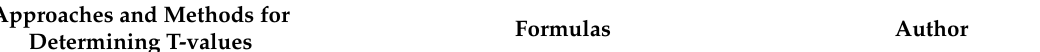
Table 1. The main approaches in determining the soil loss